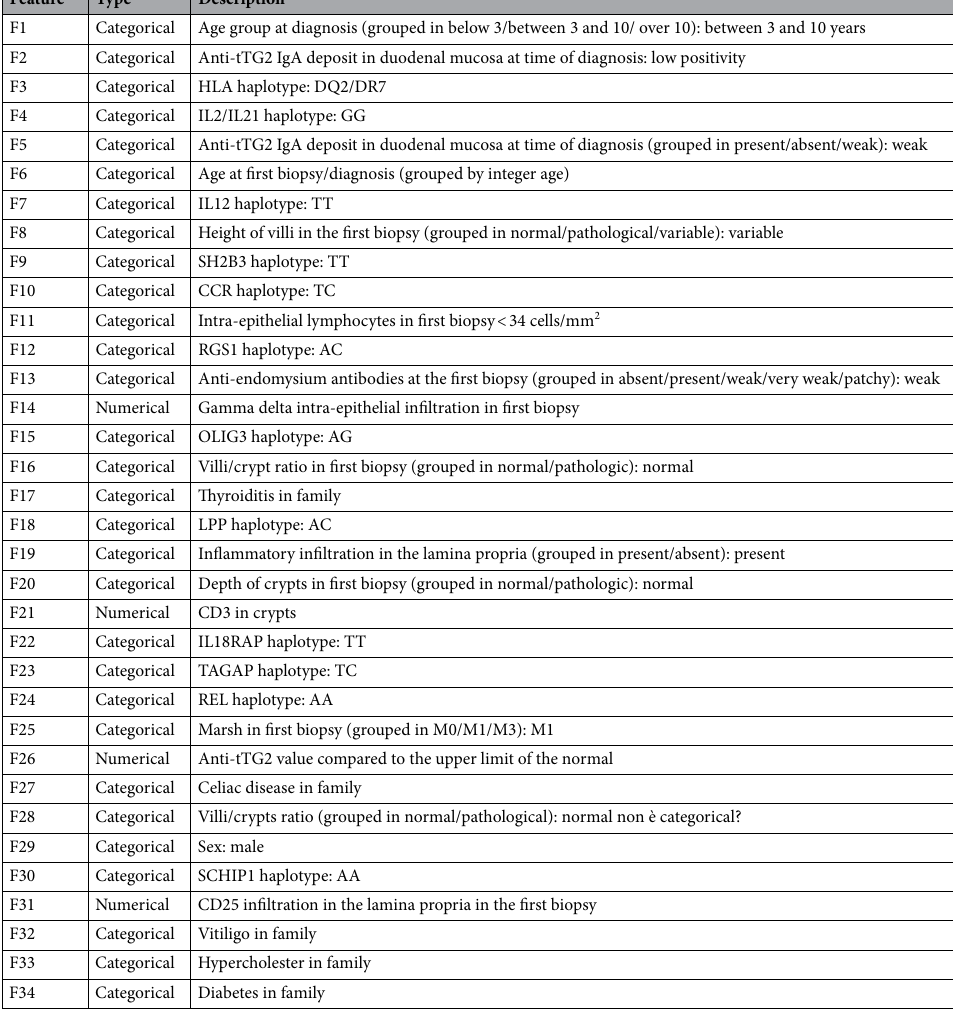
Table 1. Feature description. Features are numbered in order of relevance, as obtained by feature selection and reported starting from the most important feature. The first 19 are the one selected for the classification process, a red line has been added to divide the selected features among the others. It can be noticed that the selected features include mainly features of the child (age, age at biopsy), his genetic profile and data related to the infiltration of the Small Intestinal Mucosa (including mucosal production of anti-tTG